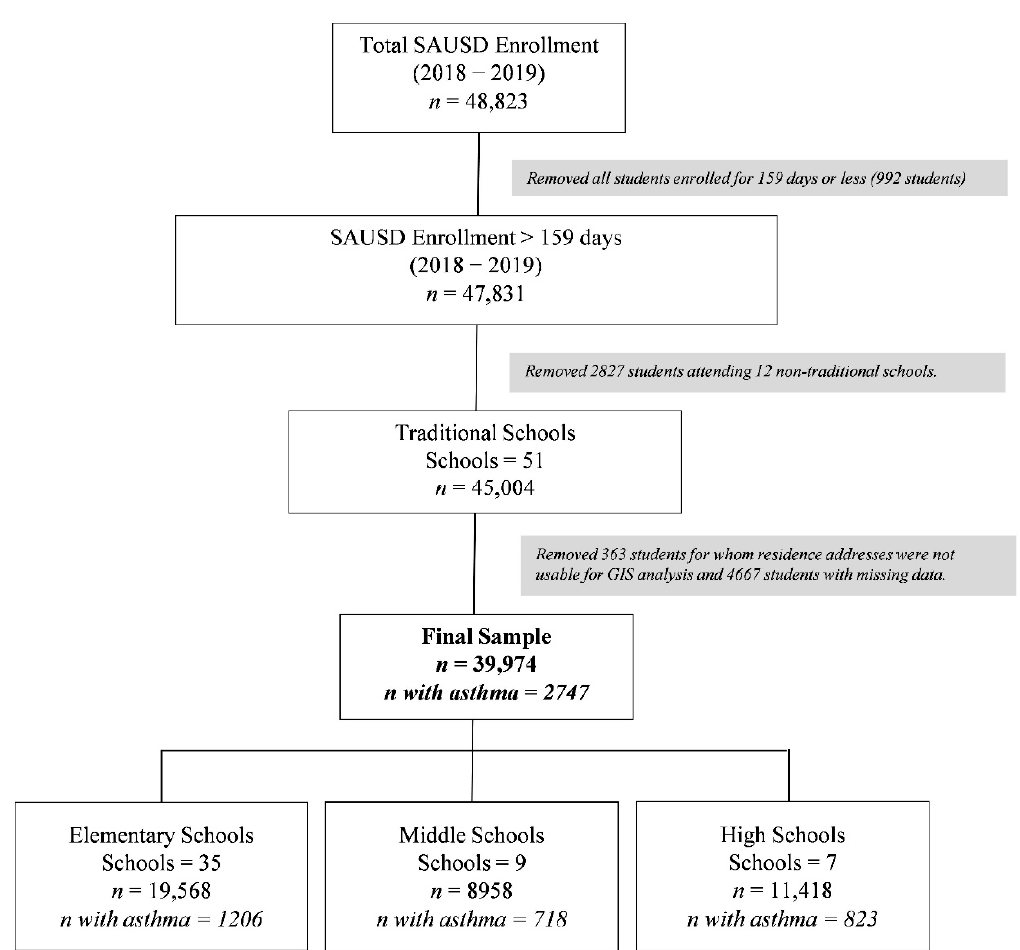
Figure 1. Study sample selection. The final sample included 39,974 students at 51 schools.